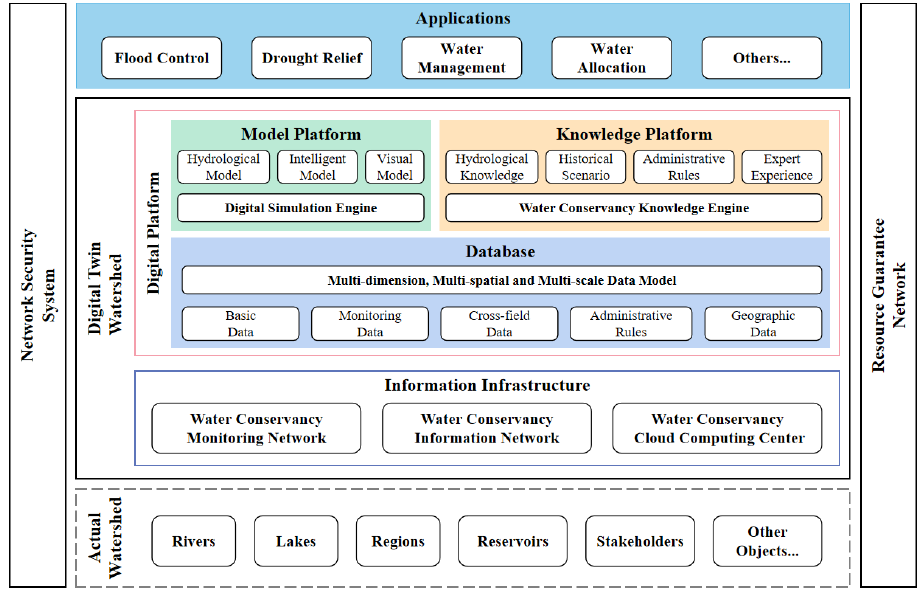
Figure 1. Framework of the National Intelligence Water Conservancy Initiative (NIWCI